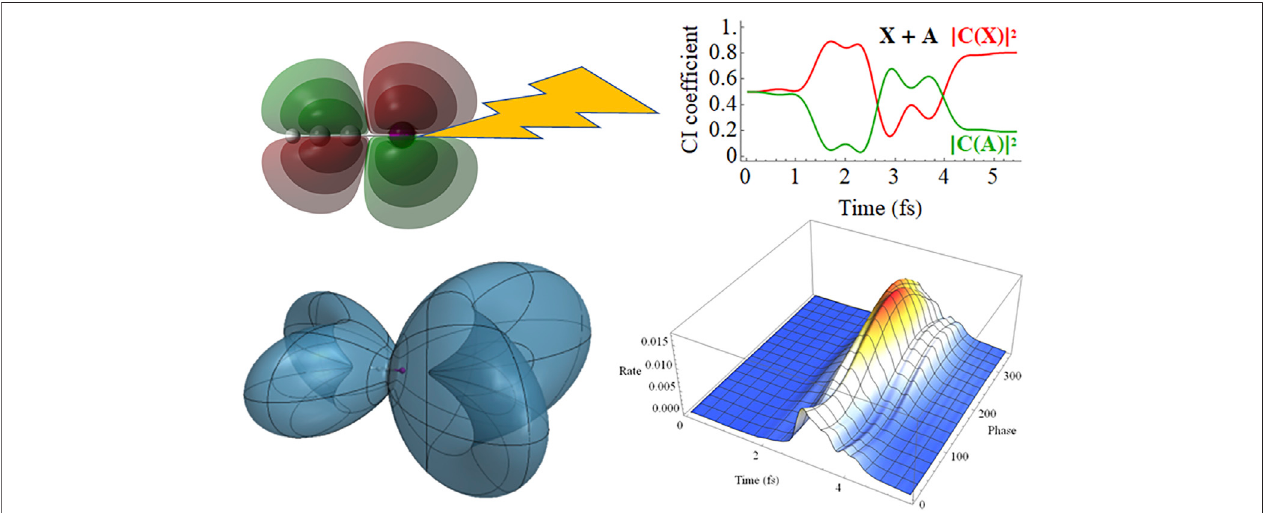
Graphical Abstract | Time-dependent con fi guration interaction simulations of the electron dynamics in coherent superpositions of the X and A cation states of HCCI show markeddifferencesin thestrong fi eldionizationratesbyintense,2cycle probepulses thatdependon theinitialphase ofthesuperpositionand onthecarrier envelope